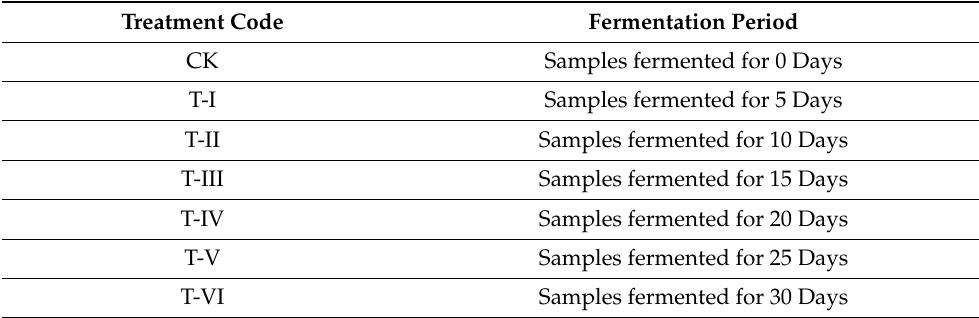
Table 1. Details of red sour soup samples fermented for different